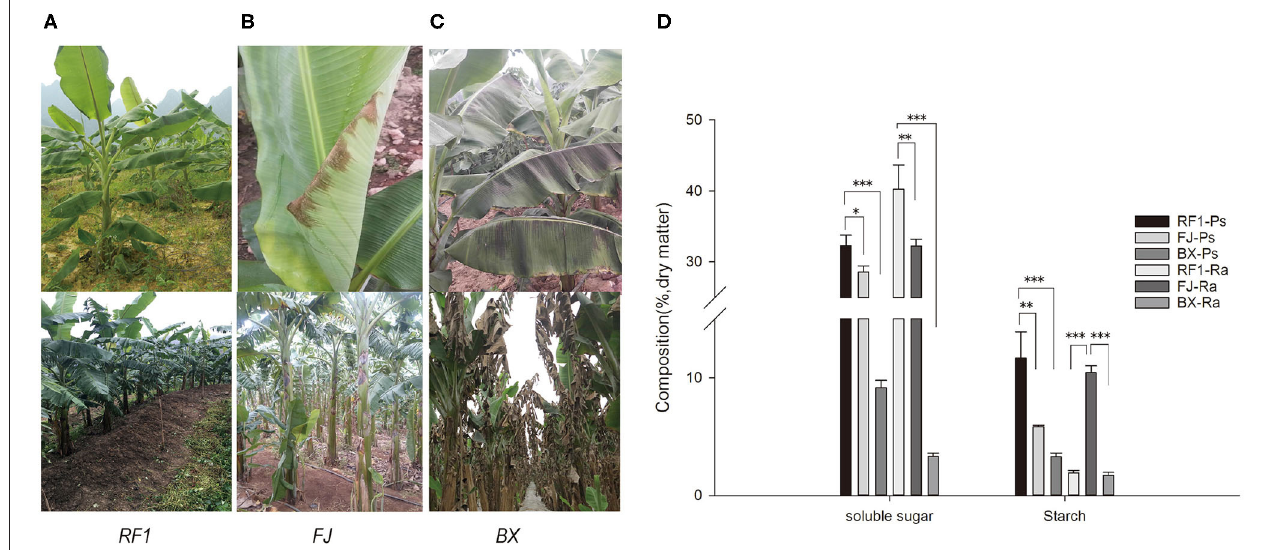
FIGURE 4 | Phenotype observations of cold tolerance and assessment of carbohydrate accumulation in RF1 mutant and cultivars (FJ and BX). (A–C) Leaf phenotypes during growth in winter at the Xingyi test site. The top images of the leaf were taken after 3 days of chilling injury. The bottom images of the leaf were taken after 14 days of chilling injury. (D) Contents of soluble sugar and starch in the pseudo-stem and rachis. Data are the mean ± SD ( n = 3); One-way ANOVA test was used to assess statistical significance (* p < 0.05; ** p < 0.01; *** p < 0.001).